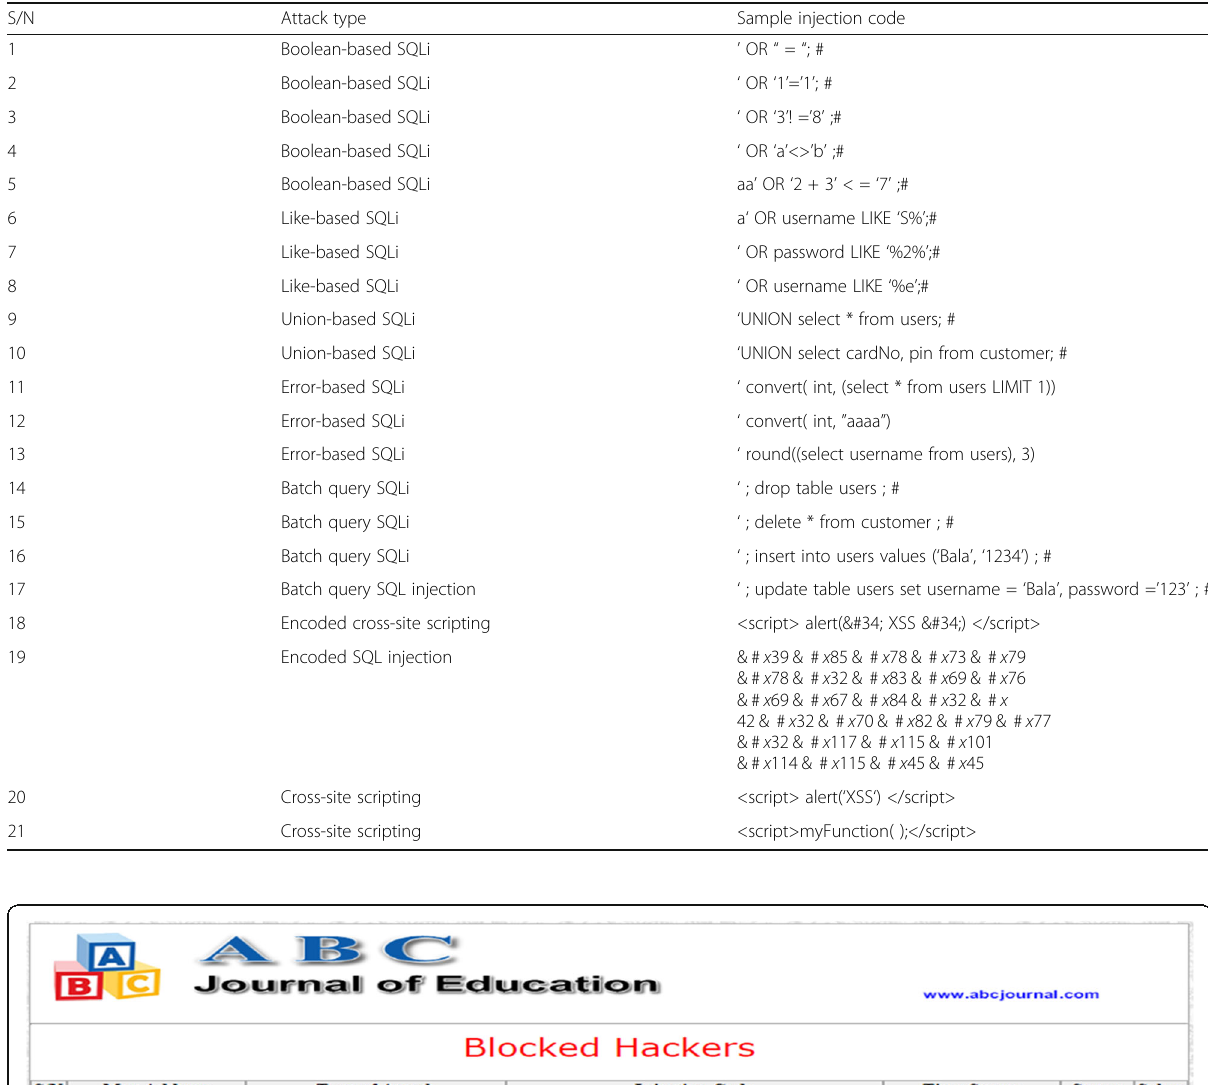
Table 4 The test plan